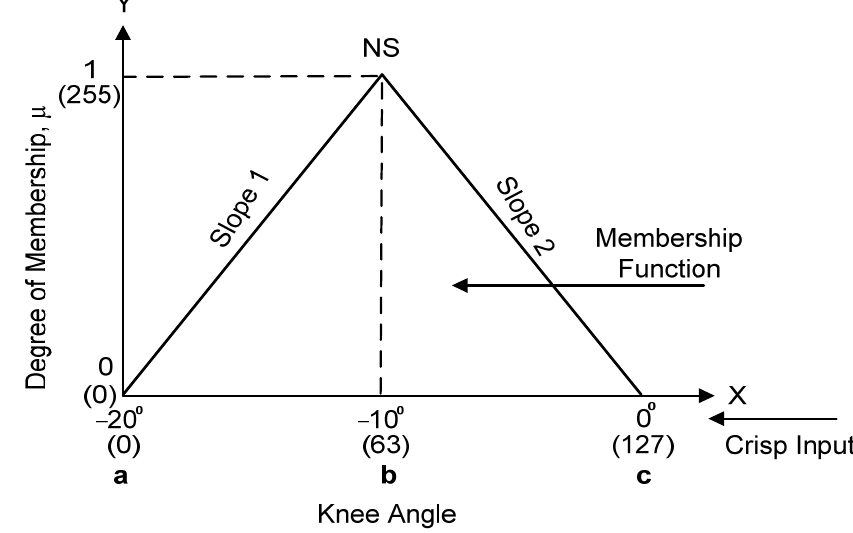
Figure 11. Example of Negative Small (NS) triangular MF for crisp input data.